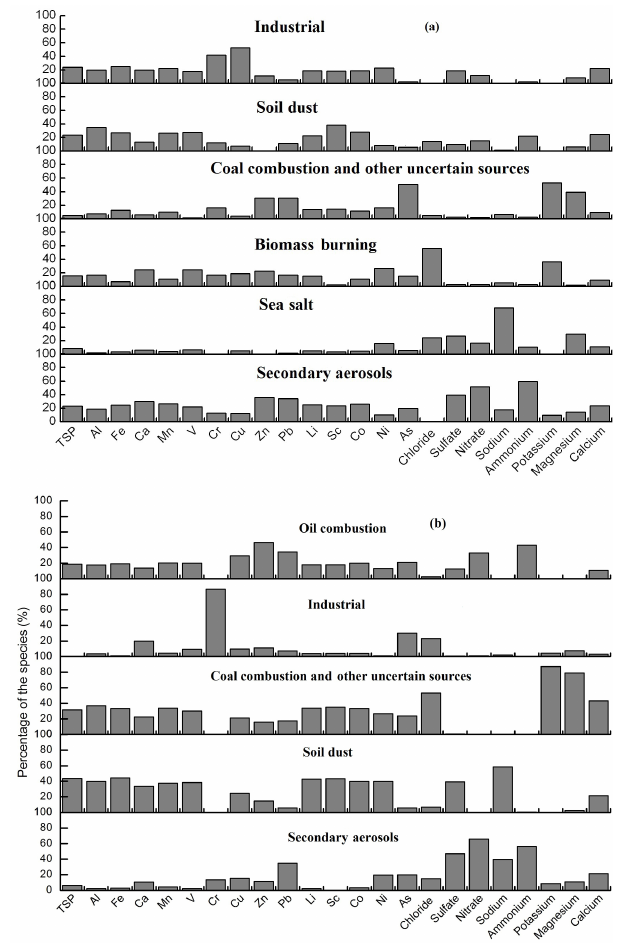
Figure 4. Source profiles of atmospheric aerosol samples collected on reference (a) and dust (b) days using the PMF model.